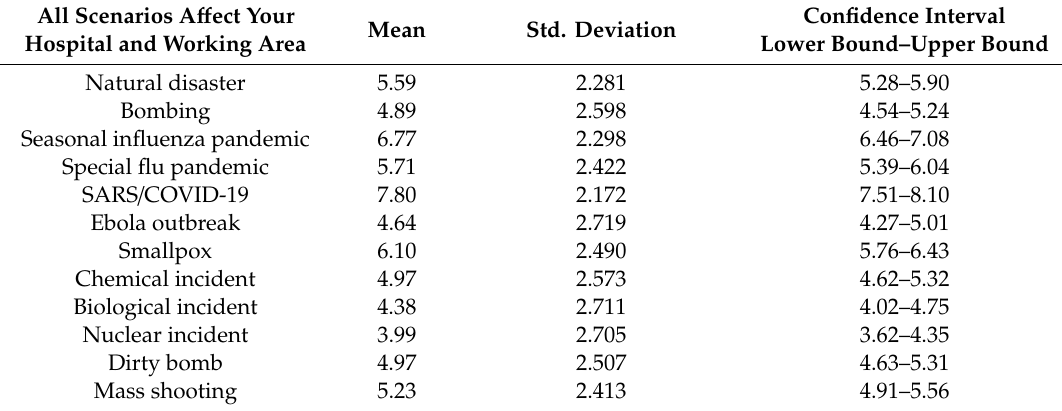
Table 4. Participants’ self-ratings of their knowledge on a Likert scale of 1 (no knowledge at all) to 10 (knowledge on specialist